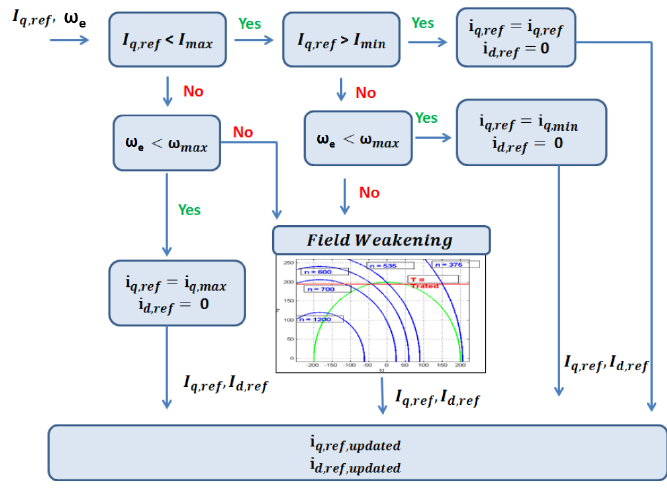
Figure 23. Description of the method for the referent current determination, adapted from [120]. A contribution by Jonas